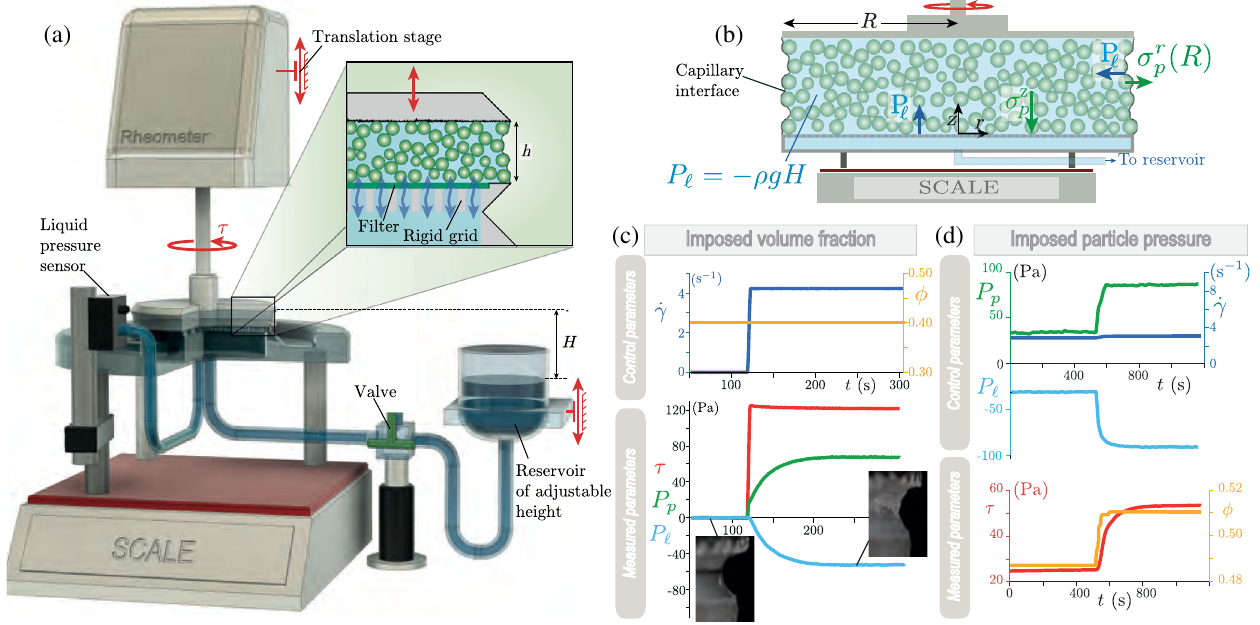
FIG. 1. Capillarytron: The concept. (a) Sketch of the capillarytron. A reservoir of adjustable height is connected to the suspension through a permeable grid to impose a negative liquid pressure P l ¼ − ρ gH : Here, the capillary interface is used to impose the particle pressure. (b) Schematic of the horizontal and vertical force balances in steady state: In the radial direction and at the air-suspension ð R Þ is balanced by the liquid pressure P capillary interface, the particle pressure σ r l . In the vertical direction, the mass m measured with p ¯ σ z the scale results from the contribution of the mean particle stress in the vertical direction and the liquid pressure P l . (c) Typical p experiment under volume-imposed condition (valve closed). The liquid pressure becomes negative as a result of the particle stress developed by the dilatant suspension. Images of the smooth and corrugated capillary interface before and during shear, respectively. (d) Typical experiment under pressure-imposed condition (valve open). Under constant shear rate and upon a sudden increase of particle pressure obtained by lowering the reservoir, the shear stress and the volume fraction self-adjust to a new steady